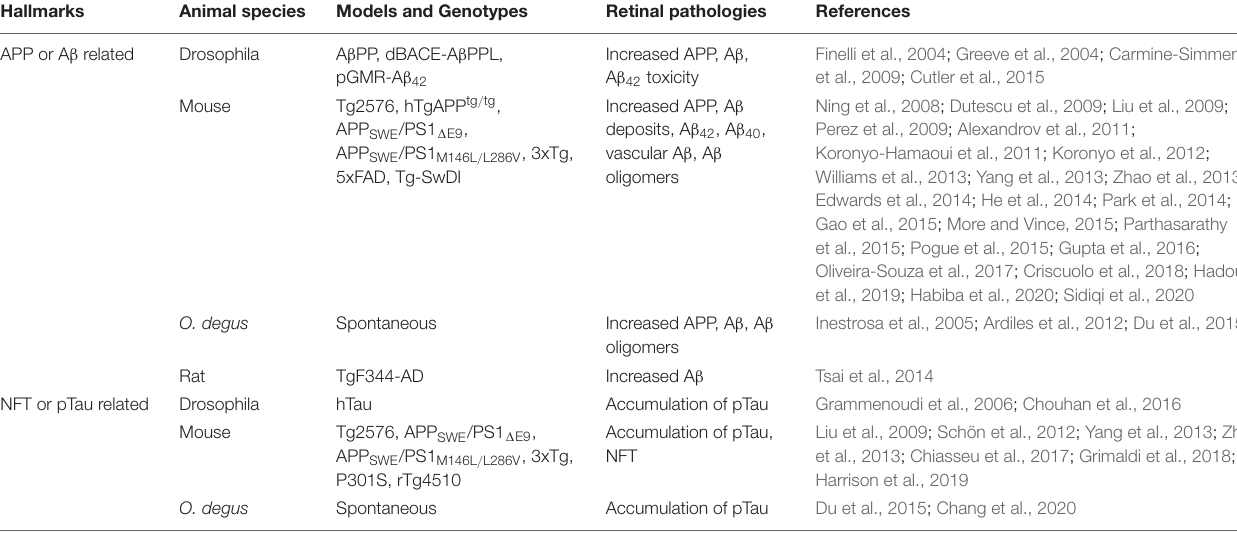
TABLE 1 | Alzheimer’s pathological hallmarks in retinas of animal